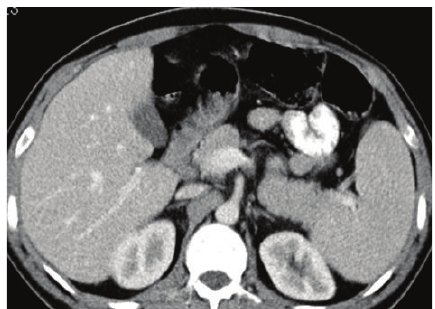
Figure 6: Axial contrast enhanced CT image of a 29-year-old male patient shows splenopancreatic fusion anomaly.